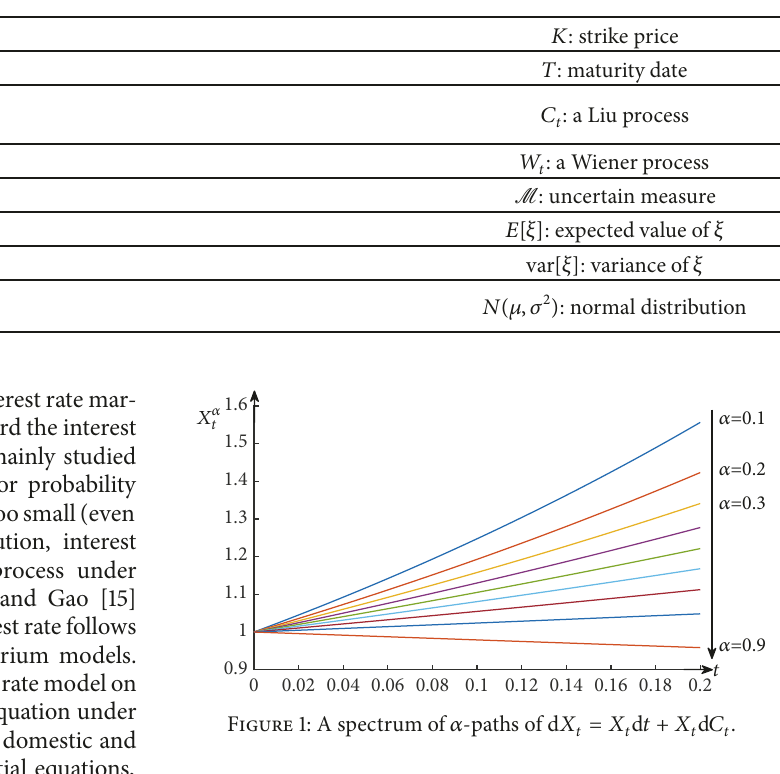
Table 1: Some notations and parameters.